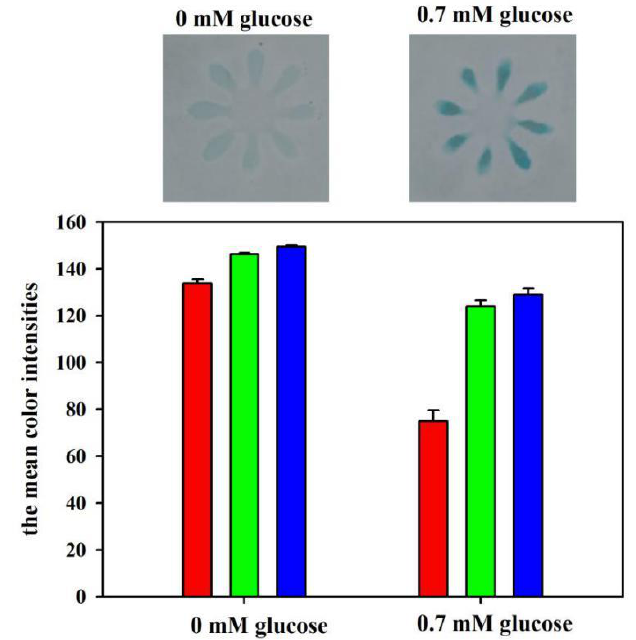
Figure 7. The color values for the developed µ PADs after reacting with the blank and the glucose standard (0.7 mM). The red, green, and blue vertical bars in the figure represent the mean colour intensities for the Red, Green, and Blue channels, respectively.